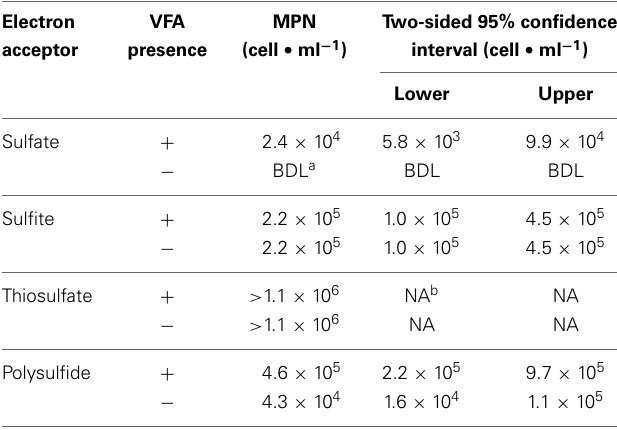
a BDL (below detection limit; < 100 cells • ml − 1 ) indicates none of the tubes were scored as positive. b NA, not applicable because all MPN tubes were positive for sulfide production with thiosulfate as electron